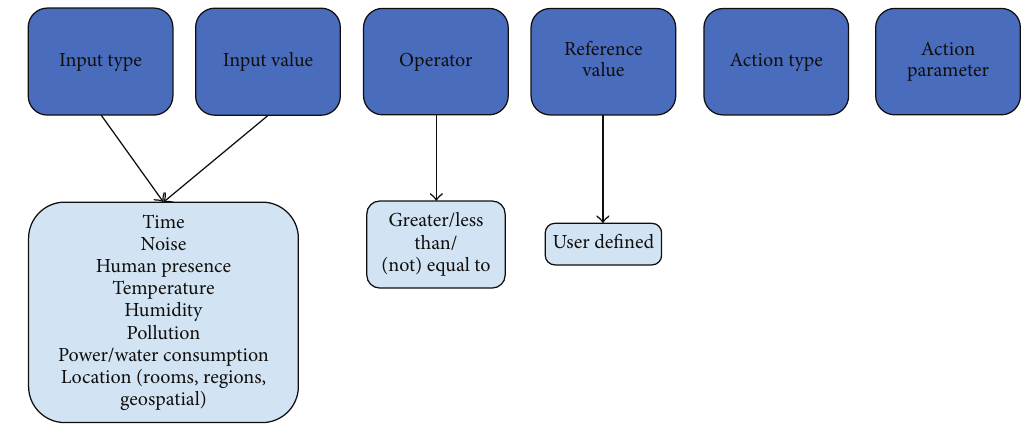
Figure 2: Home rules